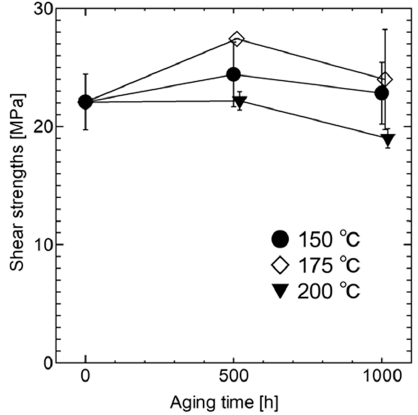
Figure 11. Shear strengths of TLPS joints aged at 150, 175, and 200 °C for 1000 h.